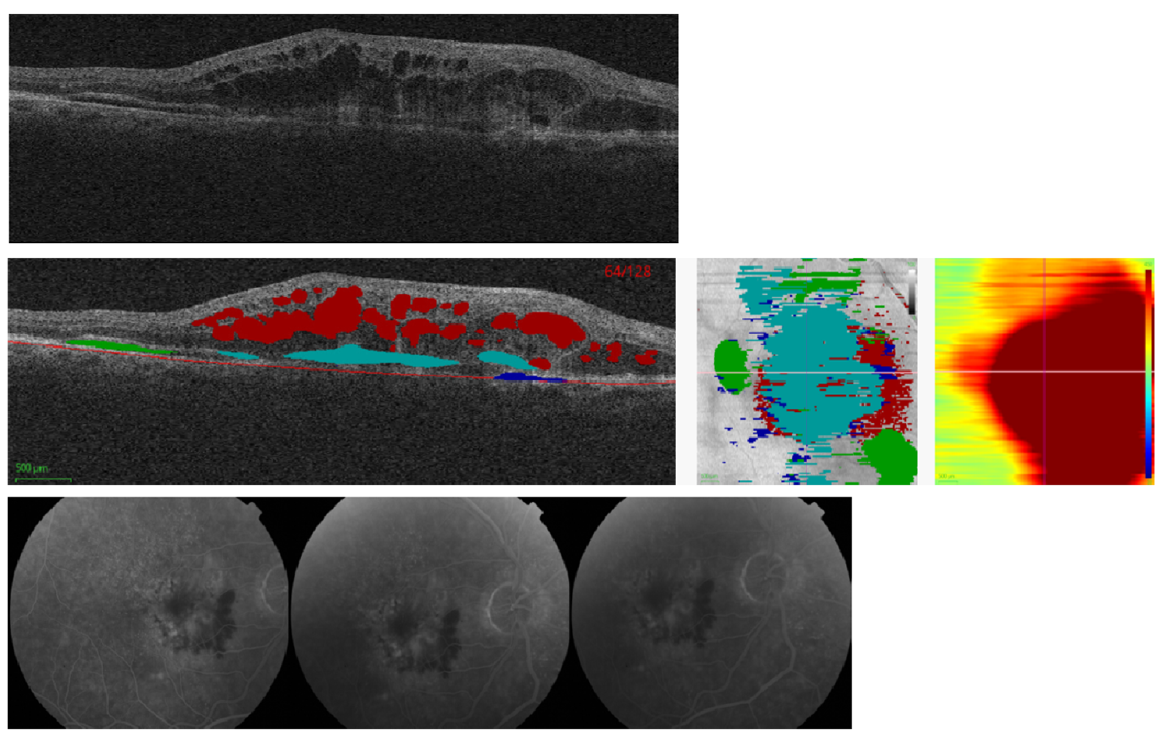
Figure 5. Representative cases showing comparison of machine algorithm with angiography. ( A–D ) Central SD-OCT B-scans (top), with segmented pixel masks of volumetric measures and Bruch’s membrane (middle left), en-face projections (middle center), and thickness maps (middle right), as well as corresponding FAs (bottom). Colors on the SD-OCT images indicate volumetric measures as follows—intraretinal fluid (red), subretinal fluid (green), PED (blue), and SHRM (cyan). Bruch’s membrane is shown as a red line. In ( A ), FA shows an area of hypofluorescence due to hemorrhage, and a well-demarcated area of hyperfluorescence due to a predominantly classic CNV that leaks in later frames. This was also identified as classic CNV by our ML algorithm, due to increased SHRM height and volume. In ( B ), FA demonstrates an ill-defined area of stippled hyperfluorescence, due to an occult CNV that leaks diffusely in mid and late frames, and was also identified as occult CNV by the ML algorithm, due to the presence of the PED. In ( C ), FA shows an area of well-defined hyperfluorescence in mid frames that stains and leaks in late frames due to fibrosis. The image was classified as classic CNV by the reading center, but was identified as occult CNV by the ML algorithm due to low SHRM height and volume. In ( D ), FA shows an area of hypofluorescence due to hemorrhage and a poorly demarcated area of hyperfluorescence due to the CNV. This lesion was defined as minimally classic by the reading center, but was identified as classic CNV by the ML algorithm due to the SHRM created by the hemorrhage. CNV, choroidal neovascularization; FA, fluorescein angiogram; ML, machine learning; PED, pigment epithelium detachment; SD-OCT, spectral-domain optical coherence tomography; and SHRM, subretinal hyperreflective